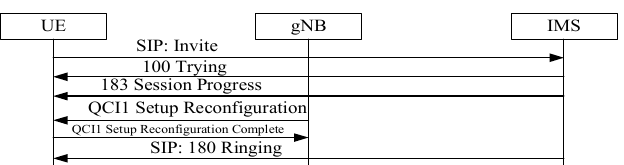
Figure 8. VoNR call setup process.